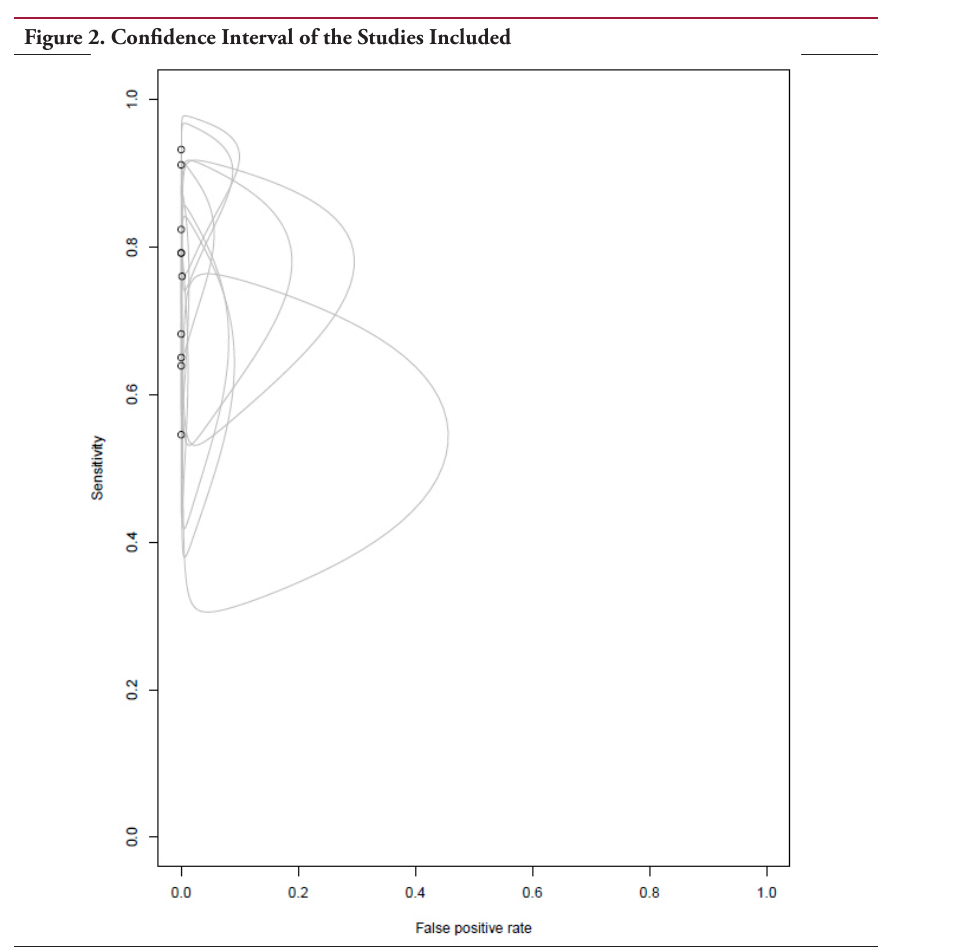
Figure 2. Confidence Interval of the Studies